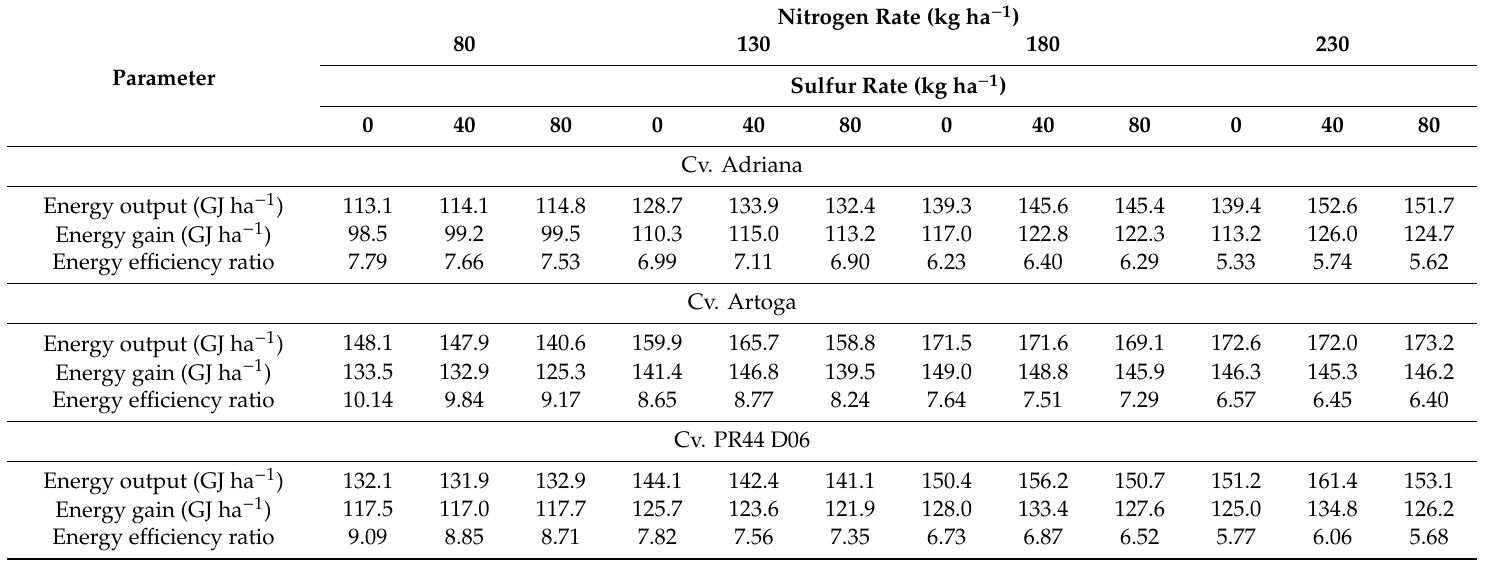
Table 14. Energy e ffi ciency of the analyzed winter oilseed rape cultivars, across years.